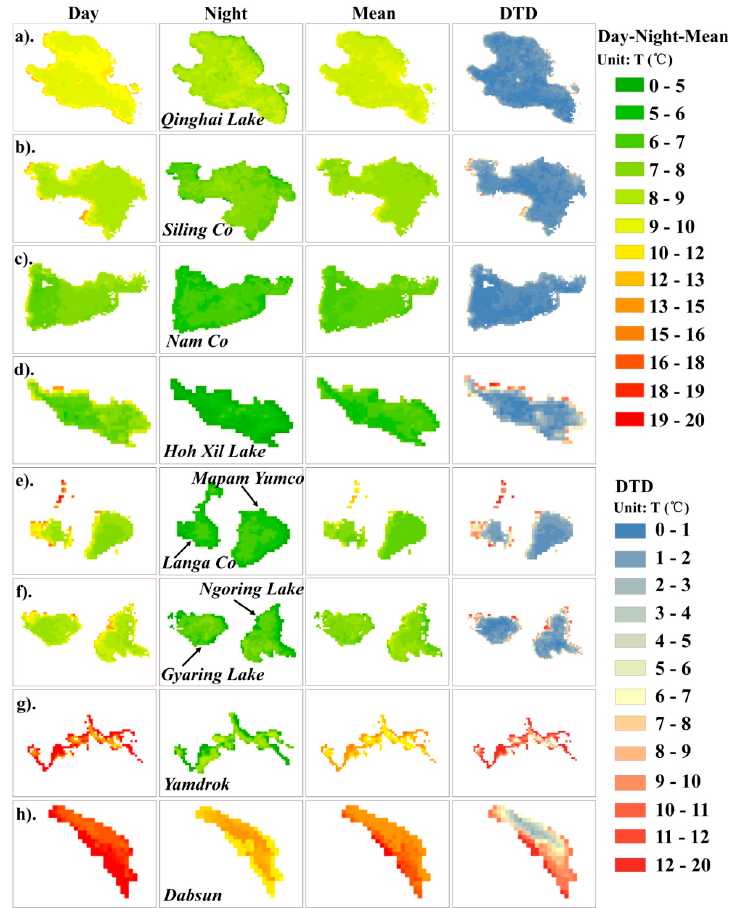
Figure 6. The spatial LWST patterns for eight typical lakes during ice-free period, column one to three are averaged daytime, nighttime, and mean of day-nighttime temperature, while column four is the averaged diurnal temperature difference (DTD): ( a ) Qinghai Lake; ( b ) Siling Co; ( c ) Nam Co; ( d ) Hoh Xil Lake; ( e ) Mapam Yumco and Langa Co; ( f ) Ngoring Lake and Gyaring Lake; ( g ) Yamdrok; ( h) Dabsun Lake.